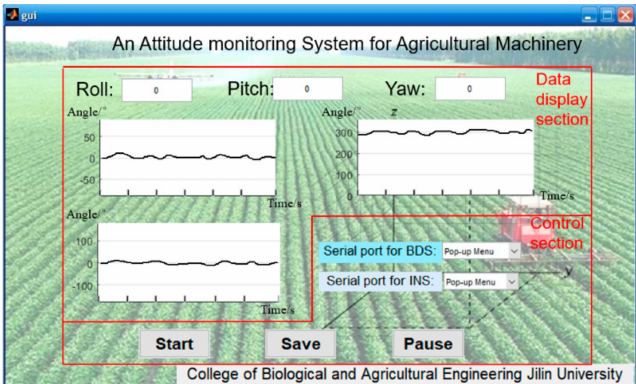
Figure 5. Man–machine interaction